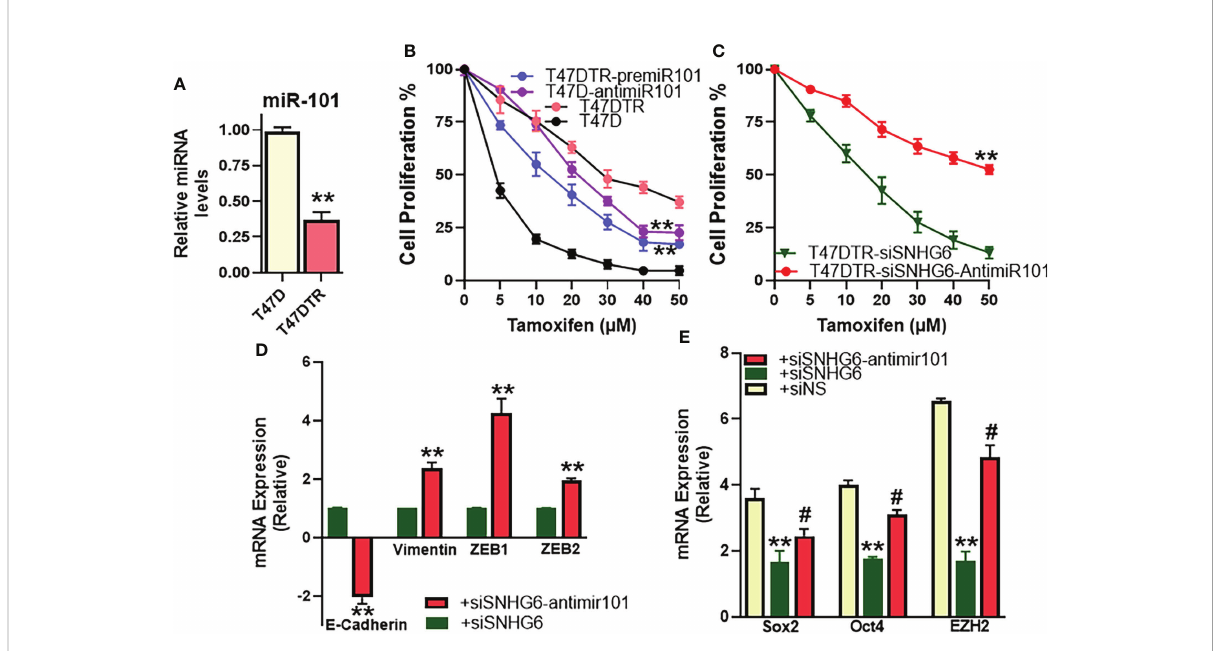
FIGURE 6 miR-101 affects validated in T47D cells. (A) Levels of miR-101 were assessed in T47DTR cells, relative to levels in parental T47D cells. Levels of miR-101 in parental cells were assigned a value of 1 and the relative levels in tamoxifen-resistant cells are plotted. (B) Cell proliferation was measured by MTT assay in T47D/T47DTR cells after transfections with pre/anti-miR-101 oligomers, as appropriate, followed by exposure to indicated concentrations of tamoxifen for 48 hours. (C) Tamoxifen resistant T47DTR either just silenced for SNHG6 or additionally transfected with anti-miR-101 oligomers were treated with increasing concentrations of tamoxifen for 48 hours before the proliferation was assessed using MTT assay. (D) T47DTR cells were silenced for SNHG6 and then the levels of EMT markers, E-cadherin, vimentin, ZEB1 and ZEB2 were evaluated by qRT-PCR in these cells as well as cells that were additionally transfected with anti-miR-101 oligomers. The levels of markers in SNHG6- silenced cells were assigned a value of 1 and the relative levels in siSNHG6+anti-miR-101-transfected cells are plotted. (E) Molecular markers of cancer stem cell phenotype, Sox2, Oct4 and EZH2 were quantitated, using qRT-PCR. The levels of miRNAs in parental T47D cells were assigned a value of 1 and the relative levels in tamoxifen-resistant control T47DTR (siNS) and those silenced for SNHG6 with and without additional transfections with anti-miR-101, are plotted. **p<0.01, compared to respective controls, #p<0.01, compared to